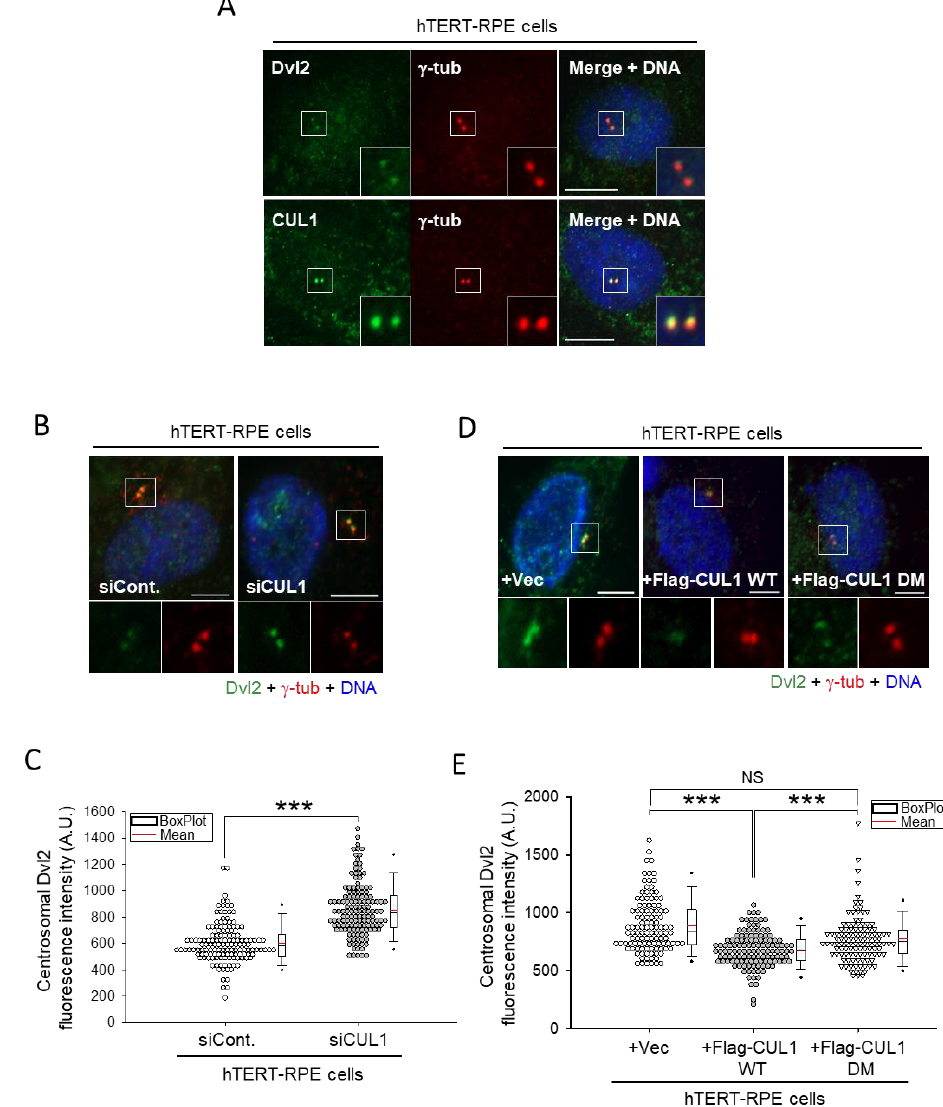
Figure 4. Amount of centrosomal Dvl2 was regulated by CUL1 activity. ( A ) Asynchronously growing hTERT-RPE cells were double-immunostained with anti-Dvl2 and anti- γ -tubulin antibodies or anti-CUL1 and anti- γ -tubulin antibodies. DNA was stained with 4′,6-diamidino-2-phenylindole (DAPI). Scale bar, 10 µ m. ( B , C ) hTERT-RPE cells transfected with either control (siCont.) or CUL1 siRNA (siCUL1) were serum-starved for 48 h. The resulting cells were subjected to immunostaining with anti-Dvl2 and anti- γ -tubulin antibodies ( B ). Scale bar, 10 µ m. DNA was stained with DAPI. The signal intensities of centrosomal Dvl2 were measured using ZEN 2 blue edition (Carl Zeiss) software and shown in a dot-density graph with a box plot ( C ). *** p < 0.001 (unpaired two-tailed t -test). More than 100 cells were measured to determine the signal intensity of centrosomal Dvl2. ( D , E ) hTERT- RPE cells transfected with control vector (-), pFlag-CUL1 WT , or DM were serum-starved for 24 h. The resulting cells were subjected to immunostaining with anti-Dvl2 and anti- -tubulin antibodies ( D ). Scale bar, 10 m. DNA was stained with DAPI. The signal intensities of centrosomal Dvl2 were measured using ZEN 2 blue edition (Carl Zeiss) software and shown in a dot-density graph with a box plot ( E ). *** p < 0.001; NS, not statistically significant (one-way ANOVA). More than 100 cells were measured to determine the signal intensity of centrosomal Dvl2. All data show representative images of three independent experiments. 2.5. CUL1 Promotes Primary Ciliogenesis through Dvl2 Downregulation It has been previously suggested that centrosomal Dvl2 mediates primary cilia dis- assembly [5]. Therefore, whether centrosomal CUL1 regulates primary ciliogenesis was investigated. To this end, primary ciliogenesis under CUL1 depletion conditions was first